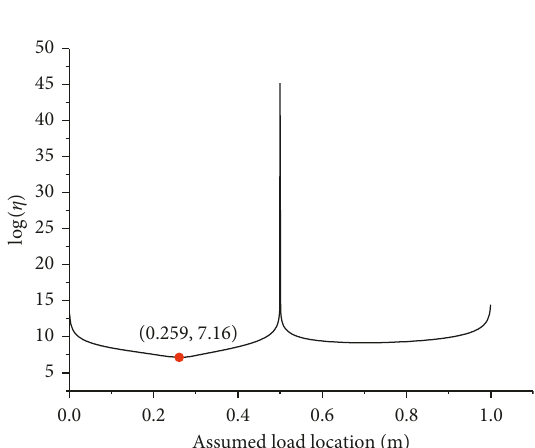
Figure 11: The L-curve plot of F